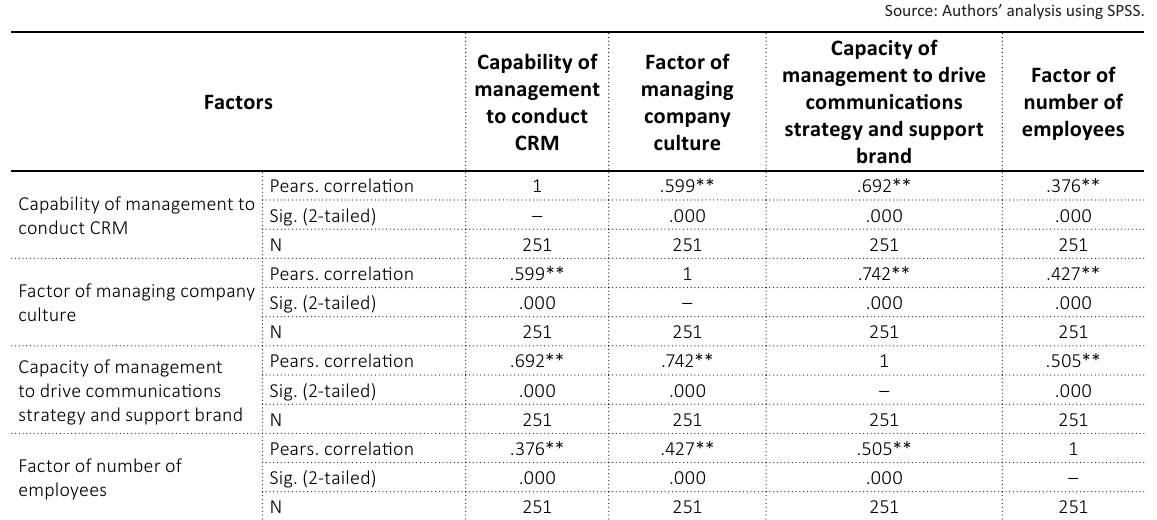
Table 9. Correlation analysis of the level of selected marketing activities of selected internal communication